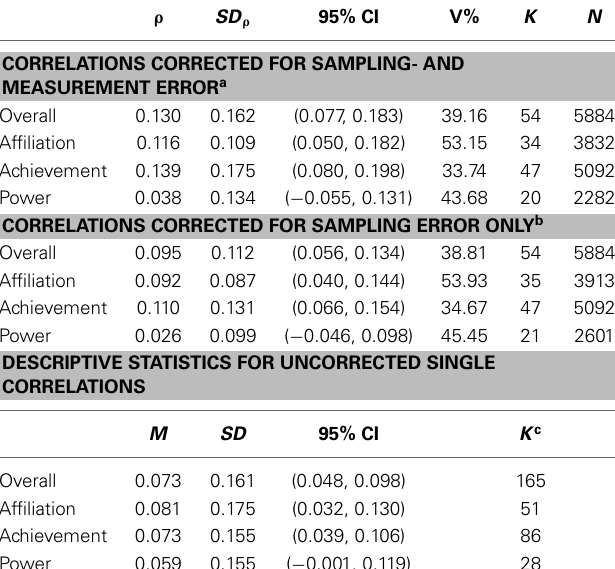
Table 4 | Meta-analytic results for overall relationship of implicit and explicit motive measures and for single motives as well as statistics for uncorrected single